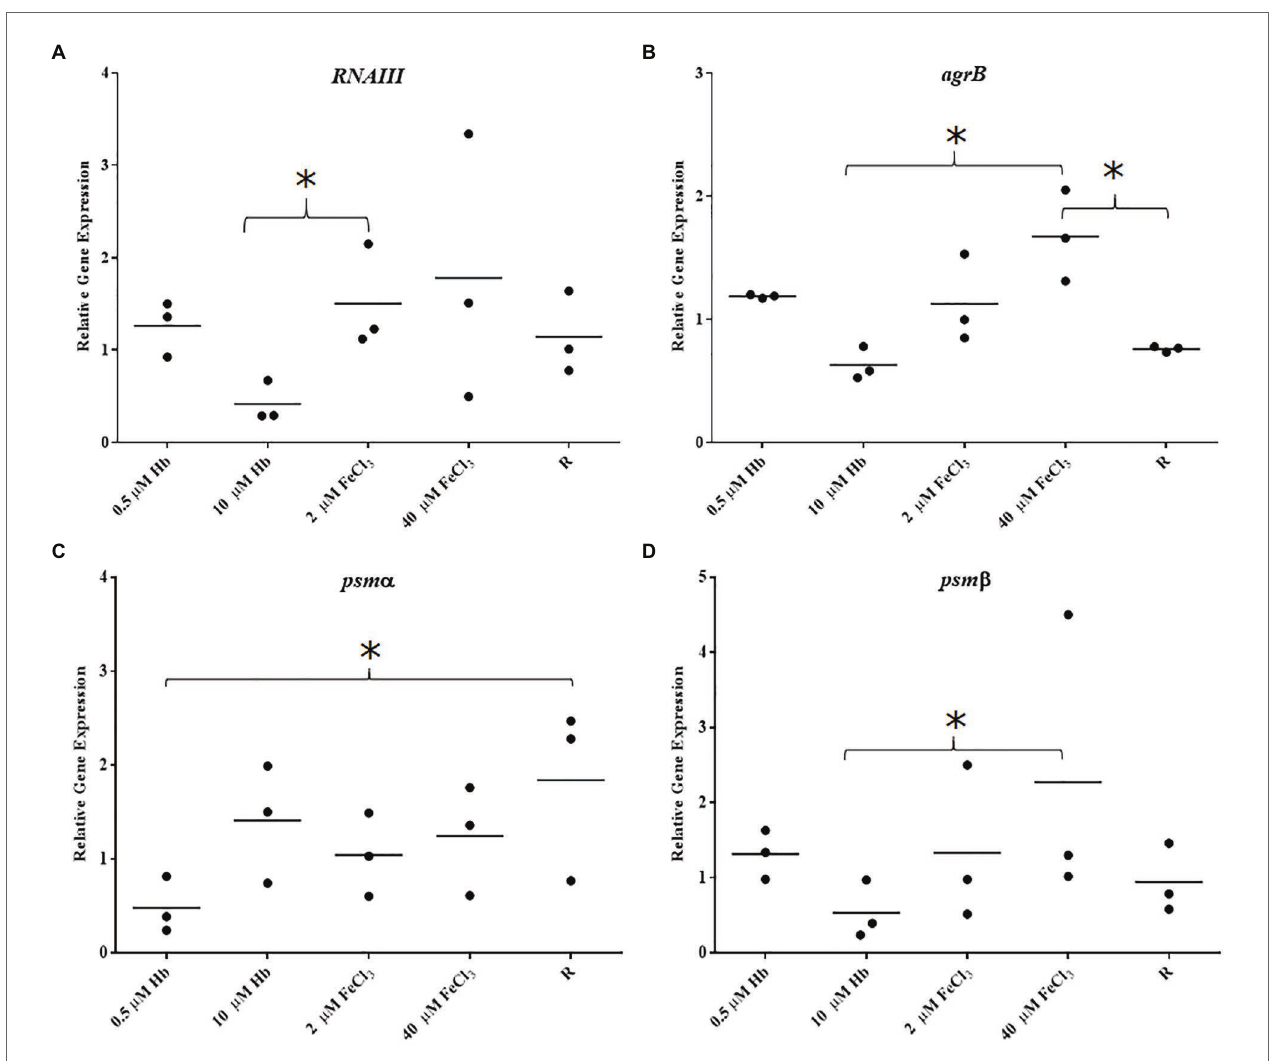
FIGURE 5 | Gene expression in biofilms of Newman. (A) , RNAIII ; (B) , agrB ; (C) , psm α ; and (D) , psm β . Data is plotted as mean of three biological replicates each including technical triplicates. Stars denote significant differences ( p < 0.05) analyzed by one-way ANOVA, Kruskall-Wallis